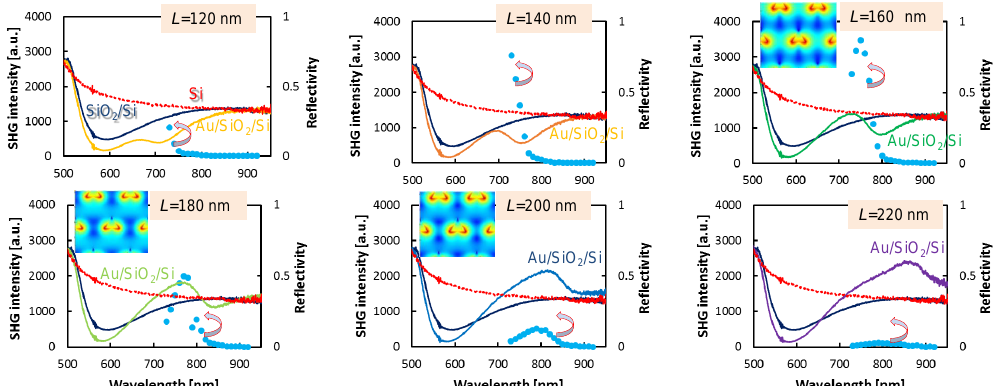
Figure 4. Plots showing experimentally measured SHG excitation spectra from metasurfaces (cyan dots, left-axis) of Au triangular nanoparticles on a SiO 2 /Si substrate with triangle side-lengths, L = 120 nm to 220 nm. Reflectivity spectra R ( λ ) (right-axis) are shown for bare Si (red), Si with SiO 2 (dark blue), and the metasurface for different size L nano-prisms (color coded). The SiO 2 spacer width was the same w = 300 nm (see Figure A1 for w = 200 nm). Polarisation of the incident field was horizontal E x . The insets show lg ( E ) maps of the calculation cell at the wavelength of maximum enhancement, which was at 824 nm for L = 160,180 nm and at 871 nm for L = 200 nm (see text for